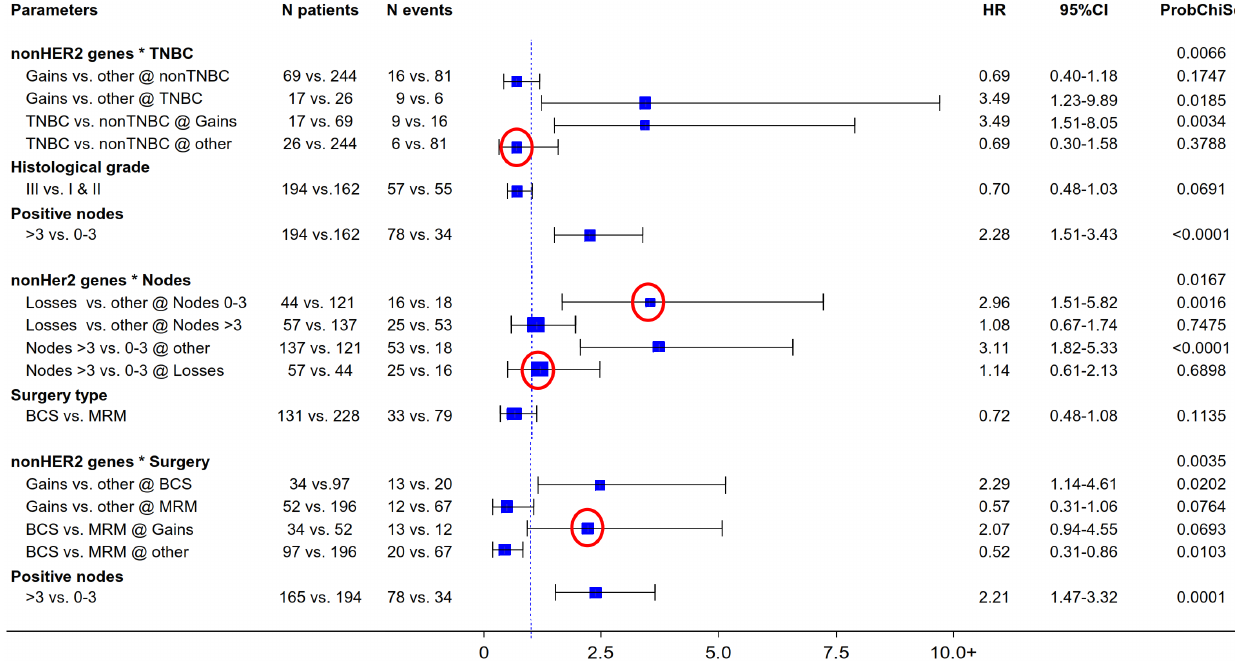
Figure 6. Multivariate analysis models involving the main significant non-HER2-gene CN genotype effects on patient DFS. Red circles: novel findings with potentially significant clinical implications, worthy pursuing for further validation. CN gains in non-HER2 genes on chr17 confer inverse risk for relapse in patients with TNBC and non-TNBC tumors, and in those who have undergone BCS in comparison to MRM. Similarly, the favorable 1–3 nodal status confers the same risk for relapse as the unfavorable disease with . 3 positive nodes, if tumors have non-HER2-gene CN losses.